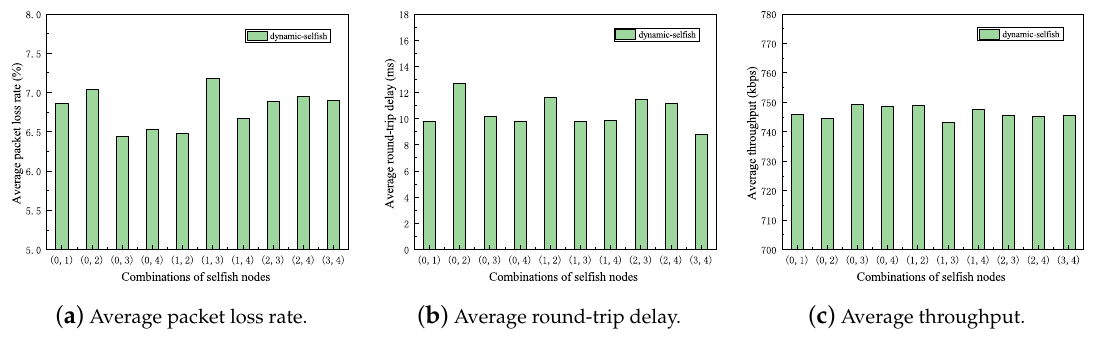
Figure 10. Performance impact of different combinations of dynamic selfish nodes (5 nodes).